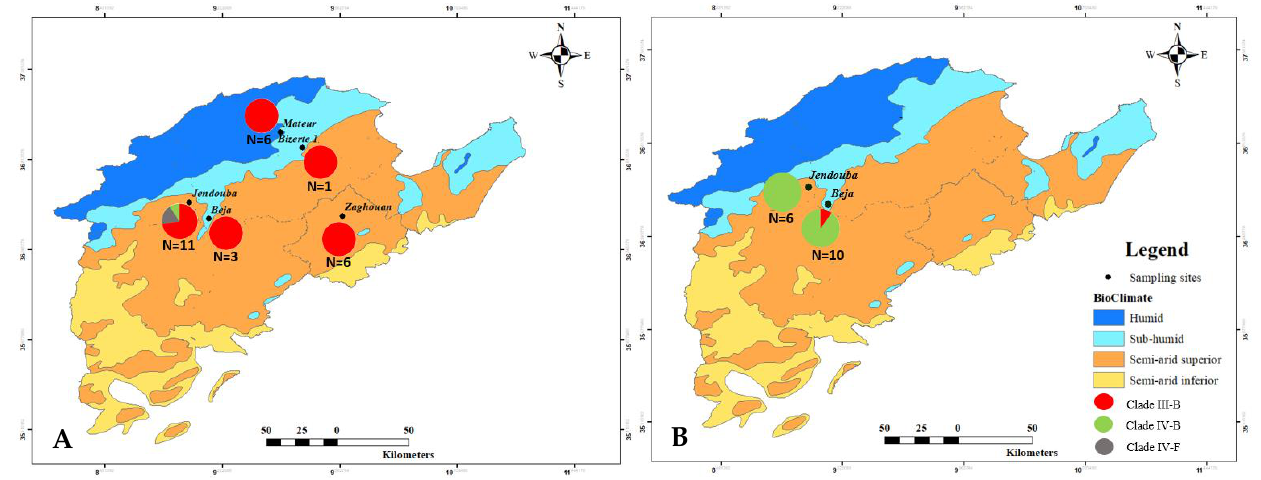
Figure 1. Pgt sampling sites (black dots) and identified clades frequencies based on number of samples (N, mentioned below pies) per site from farmer fields and trap nurseries in the northwestern region of Tunisia on 2021 ( A ) and 2022 ( B ) cropping seasons.